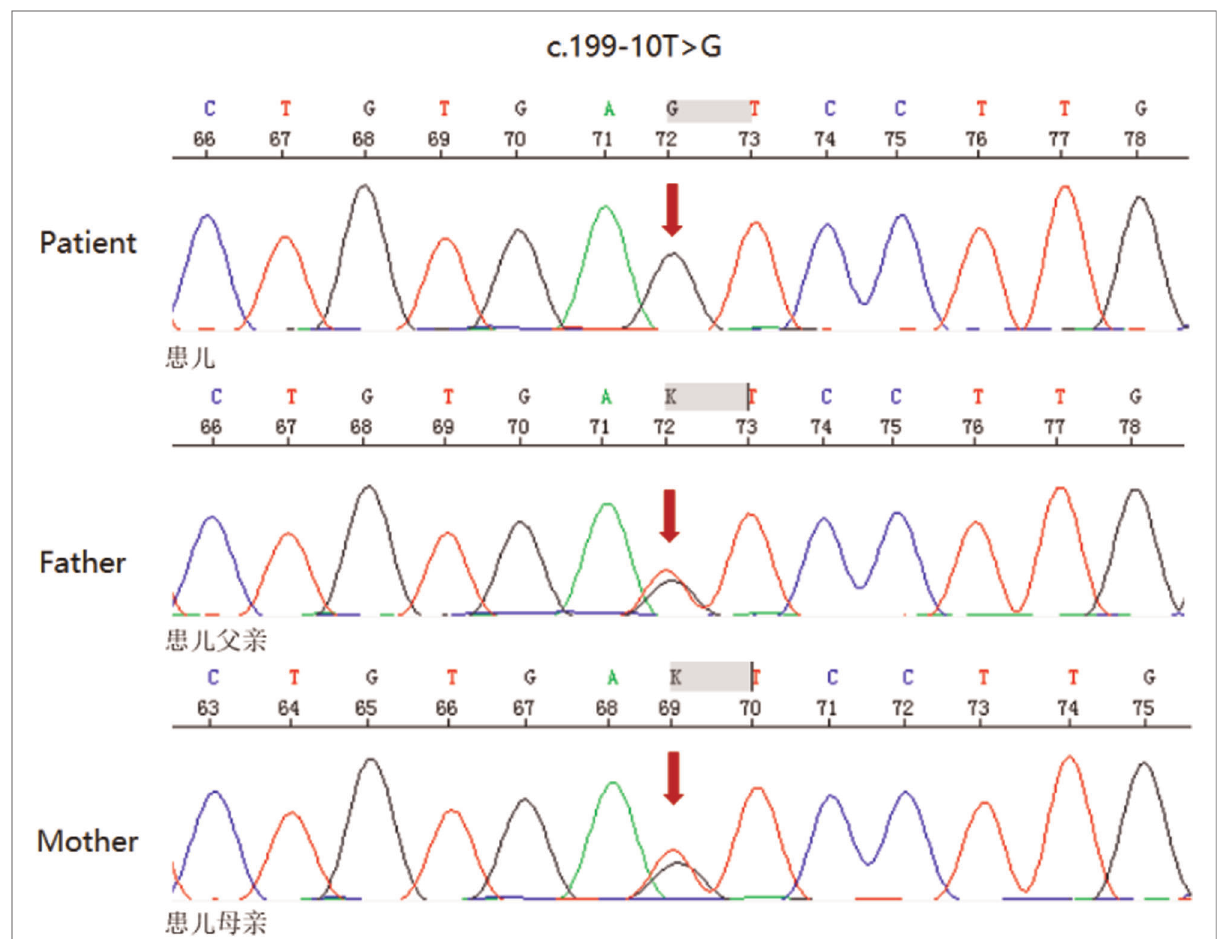
FIGURE 1 DNA sequence of SLC25A20 gene (a homozygous mutation of patient for maternally and paternally-inherited c.199 – 10 T>G variant. Parents were heterozygous carriers of the mutation. Mutation sites are indicated by red